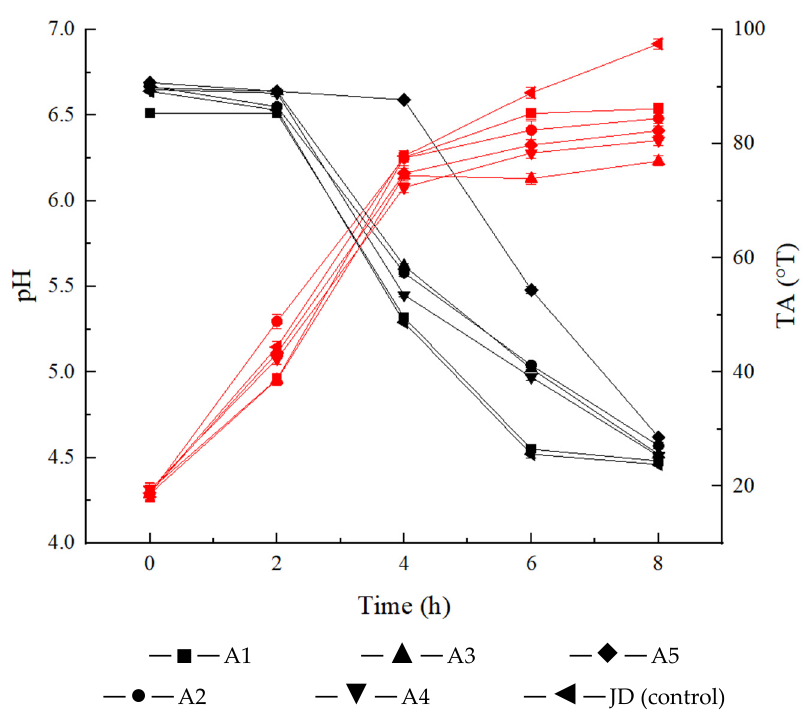
Figure 1. Changes in pH and TA during fermentation. The black and red lines represent pH and TA of the samples, respectively.